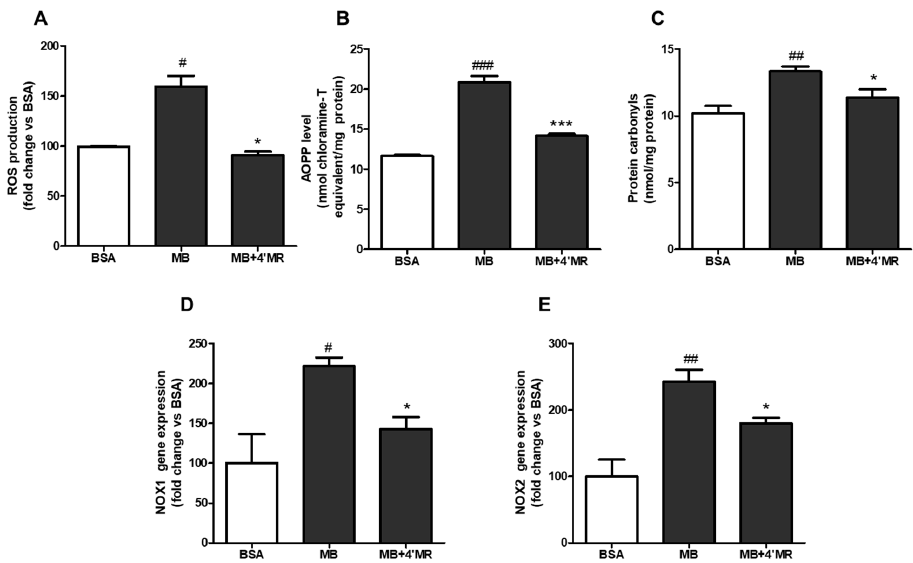
Figure 2. 4 ′ -Methoxyresveratrol alleviated oxidative stress induced by MB in RAW264.7 macrophages. ( A ) The ROS production induced by MB was determined by DCFH-DA. ( B , C ) The levels of protein carbonyls ( B ) and AOPP ( C ) were measured by a protein carbonyl assay kit and chemical method, respectively. ( D , E ) mRNA expressions of NOX1 ( D ) and NOX2 ( E ) were measured by qPCR. Gene expression was normalized to 18S. Cells were treated with 200 µg/mL BSA or MB with or without 10 µM 4 ′ MR for 24 h. All data are averages of triplicates from three separate experiments. # p < 0.05, ## p < 0.01, ### p < 0.001 vs. BSA; * p < 0.05, *** p < 0.001 vs. MB. 4 ′ MR, 4 ′ -Methoxyresveratrol.